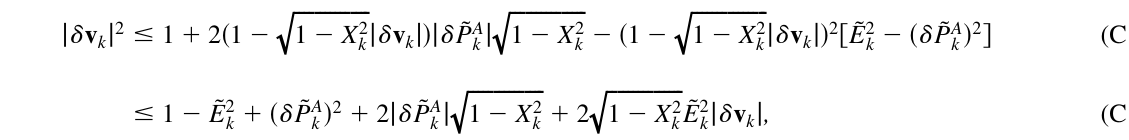
ffiffiffiffiffiffiffiffiffiffiffiffiffiffiffi